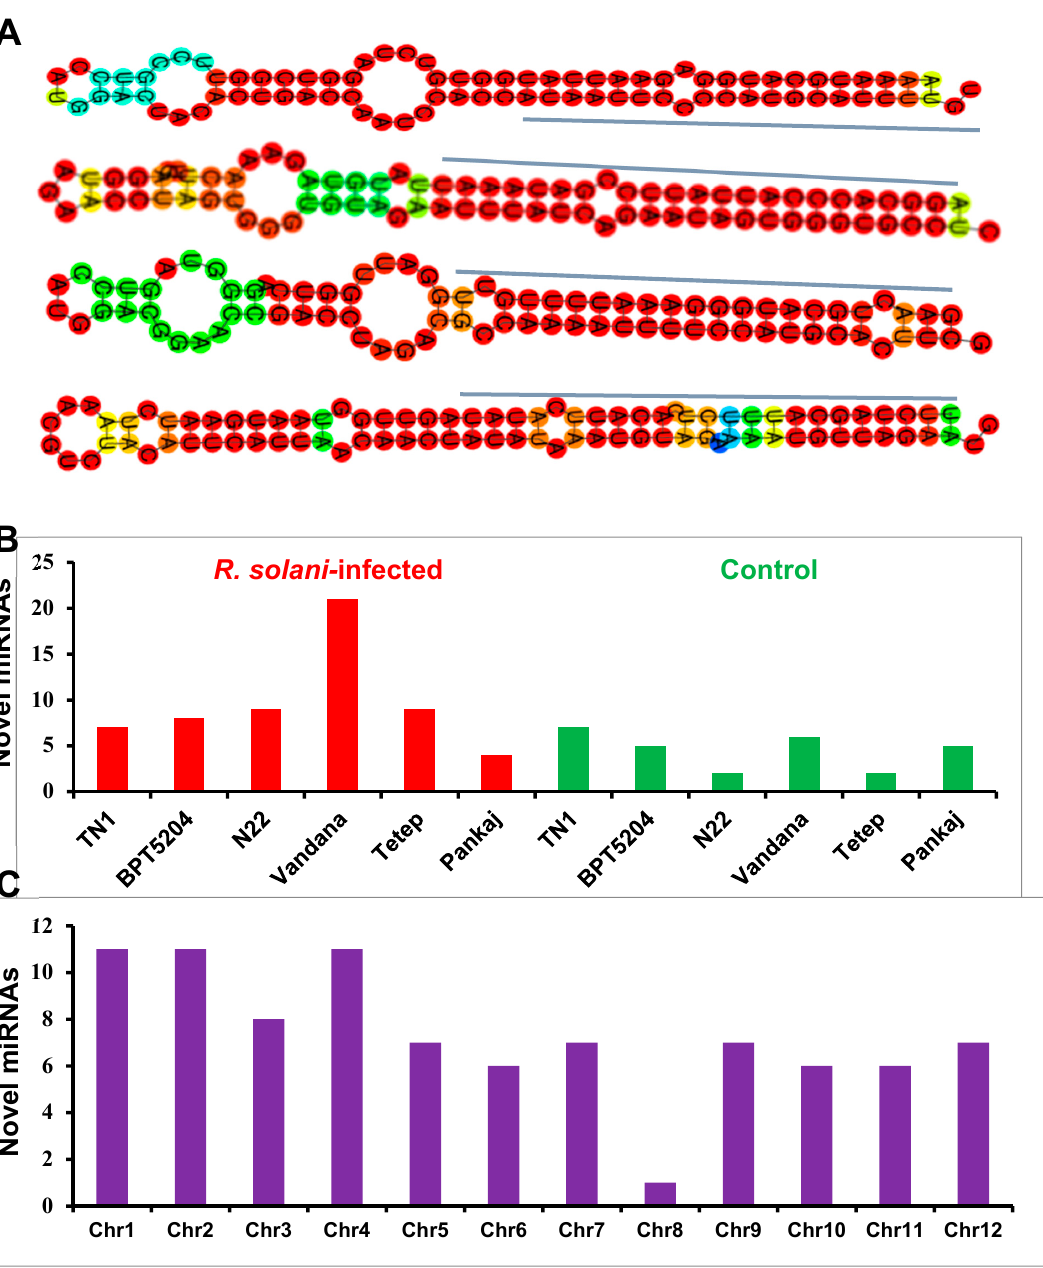
Figure 2. Novel miRNAs identified in small RNA libraries. ( A ) Predicted hairpin structures of precursor sequences of four novel miRNAs. The mature miRNA sequences are marked with blue color lines. ( B ) Distribution of novel miRNAs among infected (red color bars) and control (green color bars) samples. ( C ) Distribution of novel miRNAs in different chromosomes of the rice genome.